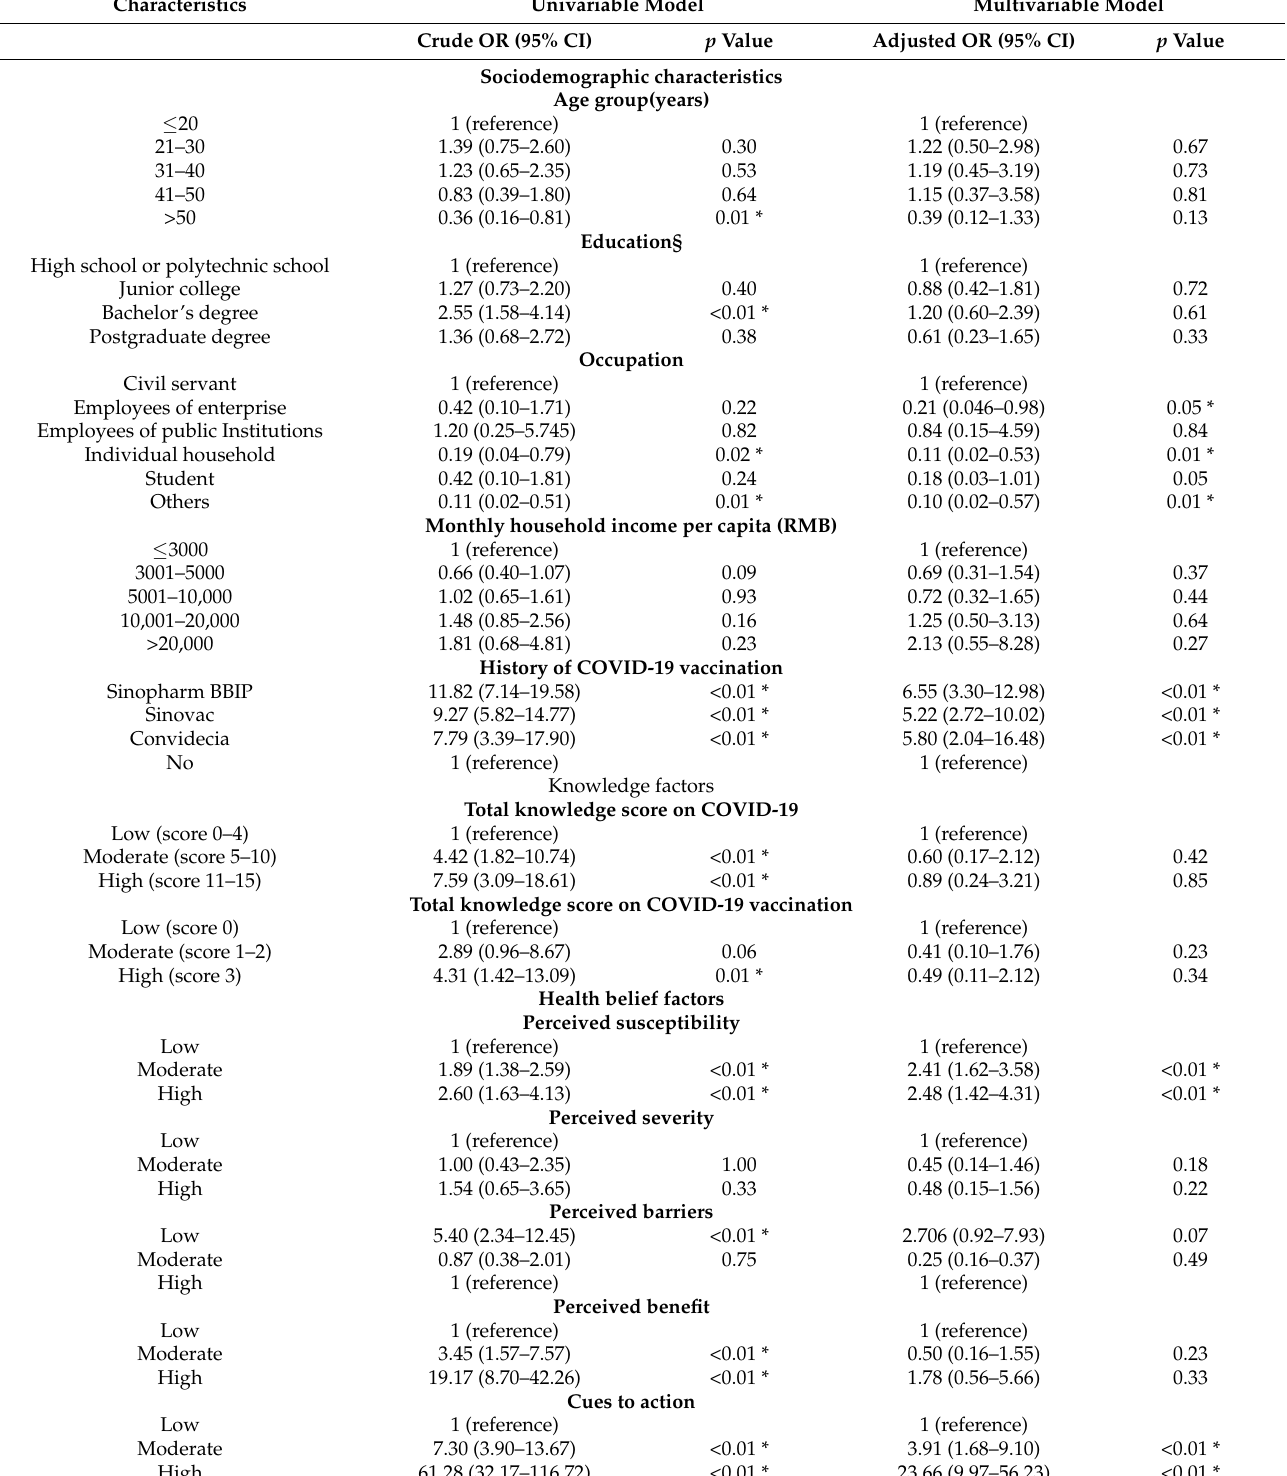
Table 3. Factors associated with the acceptance of a third dose of COVID-19 vaccine (n = 3119).